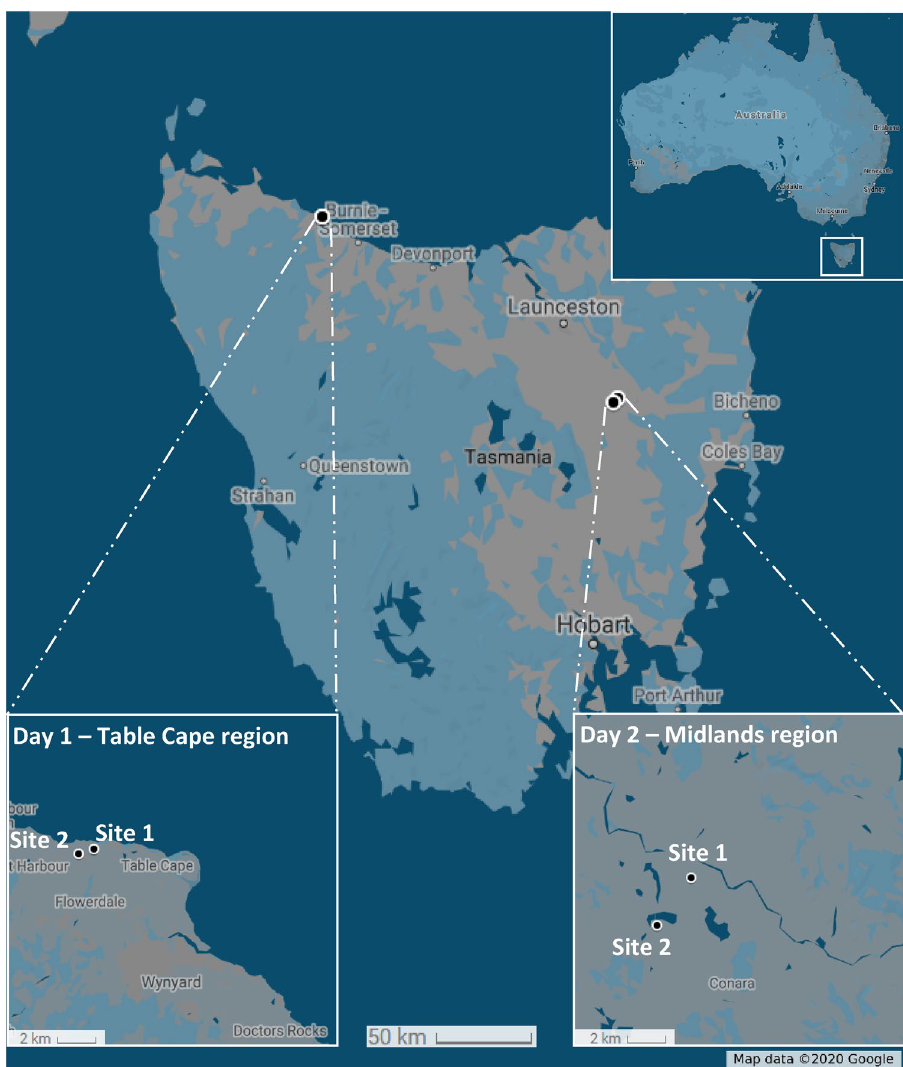
Figure 3. Map showing sampling locations in Tasmania